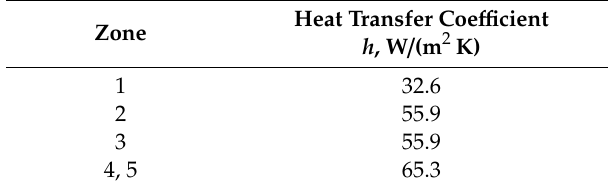
Figure 7. Areas of different convection coefficient h applied in braking simulations [34]. Table 6. Convection coe ffi cient values in the various wheel surface zones [34].